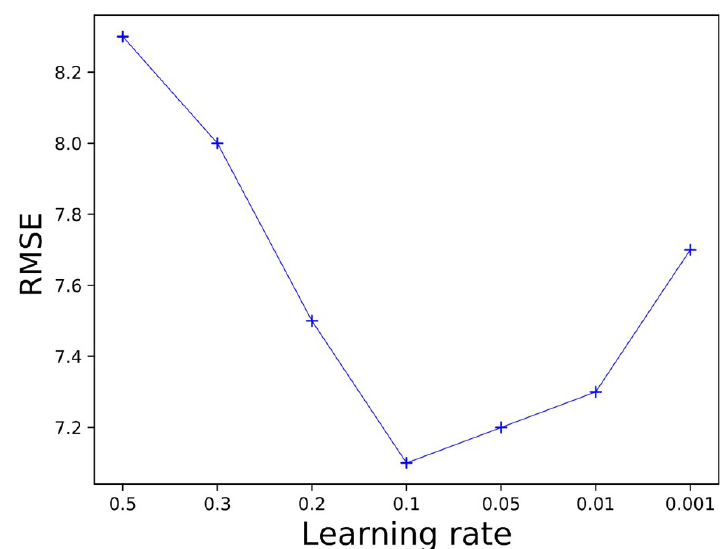
Figure 16. The relationship between Learning rate and RMSE.